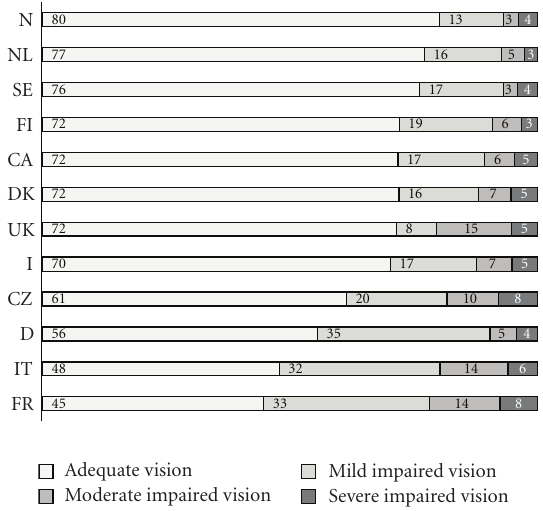
Figure 1: Vision (based on self- and proxy reports and assessed by a simple reading test) in older people receiving homecare in 12 di ff erent country sites (%); N = 106328.